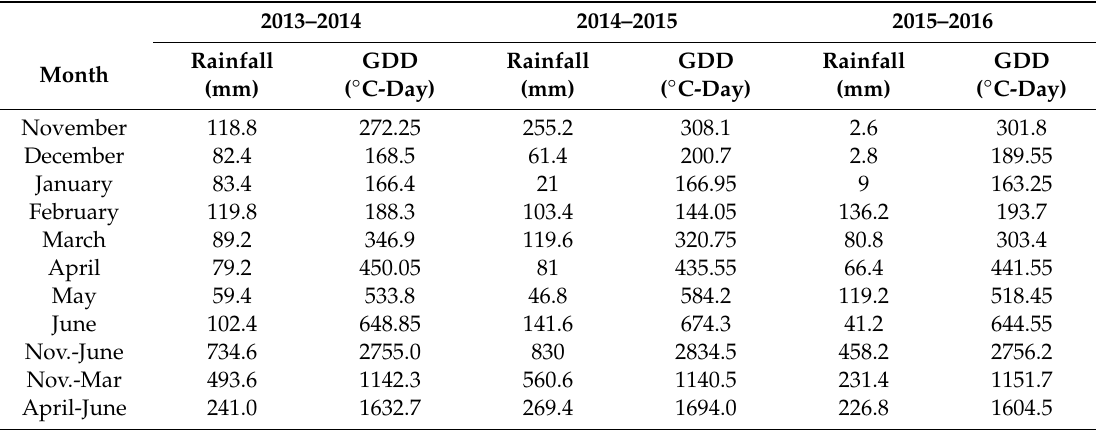
Table 3. Monthly rainfall and growing degree days (GDD) observed at Grugliasco from sowing to the end of ripening in the period 2013–2016 ¥